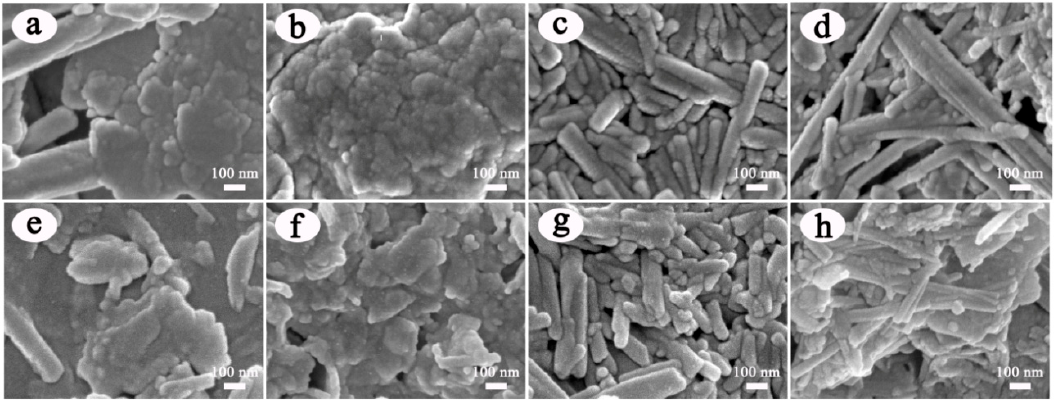
Figure 3. SEM images of ( a ) Kal, ( b ) Mt, ( c ) Hal, ( d ) Sep, ( e ) ACN / Kal, ( f ) ACN / Mt, ( g ) ACN / Hal and ( h ) ACN / Sep.